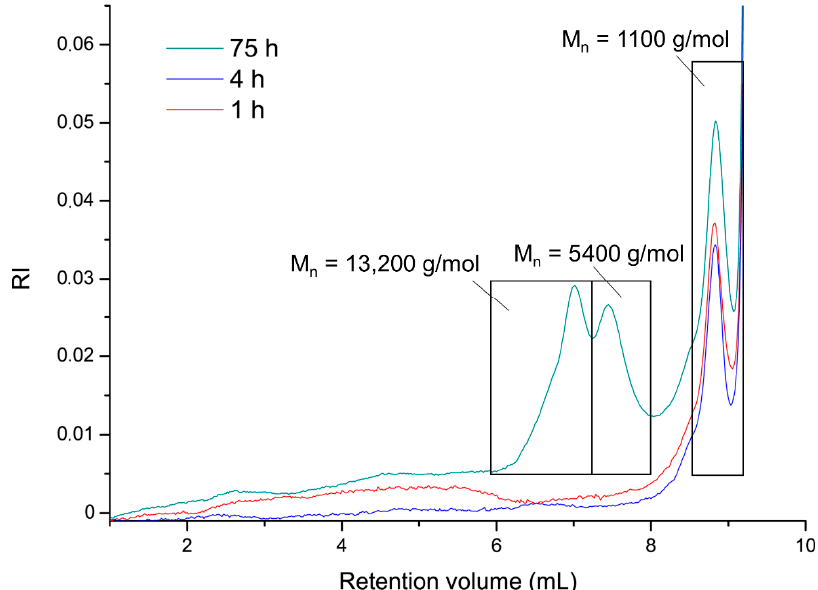
Figure 5. The peptide coupling between the two bifunctional catalysts 4 and 8 can be followed via GPC. It is expected that the reaction follows a step-growth mechanism due to its polycondensation character. This is proven by GPC where the formation of the dimer is observed early during the reaction. The formation of higher molecular weight species is only observed, if most of the monomer is consumed (75 h).